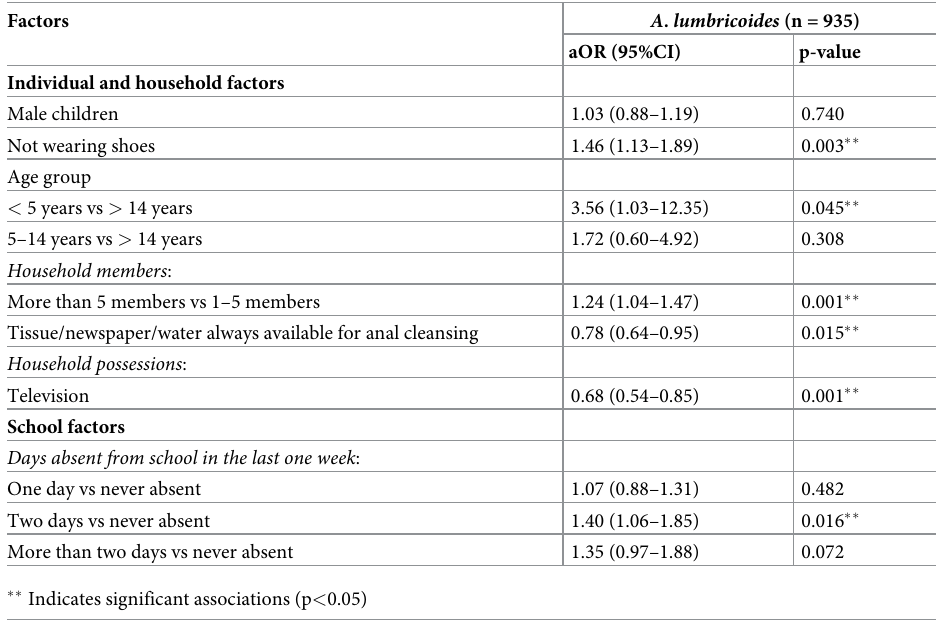
Table 10. Multivariable associations between WASH conditions and Ascaris lumbricoides infection among school children in Kenya after five rounds of